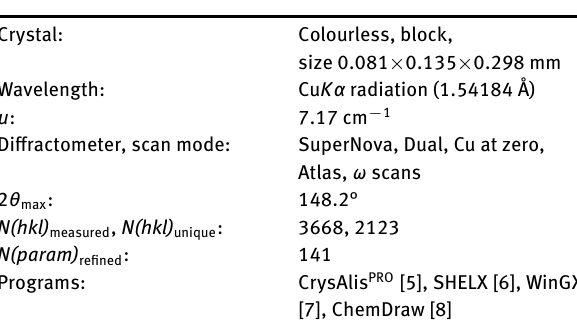
Table 1: Data collection and handling.